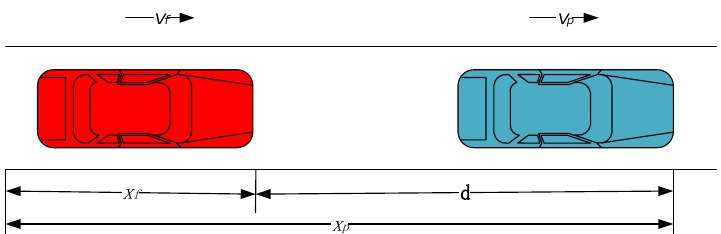
x is the target vehicle position, p